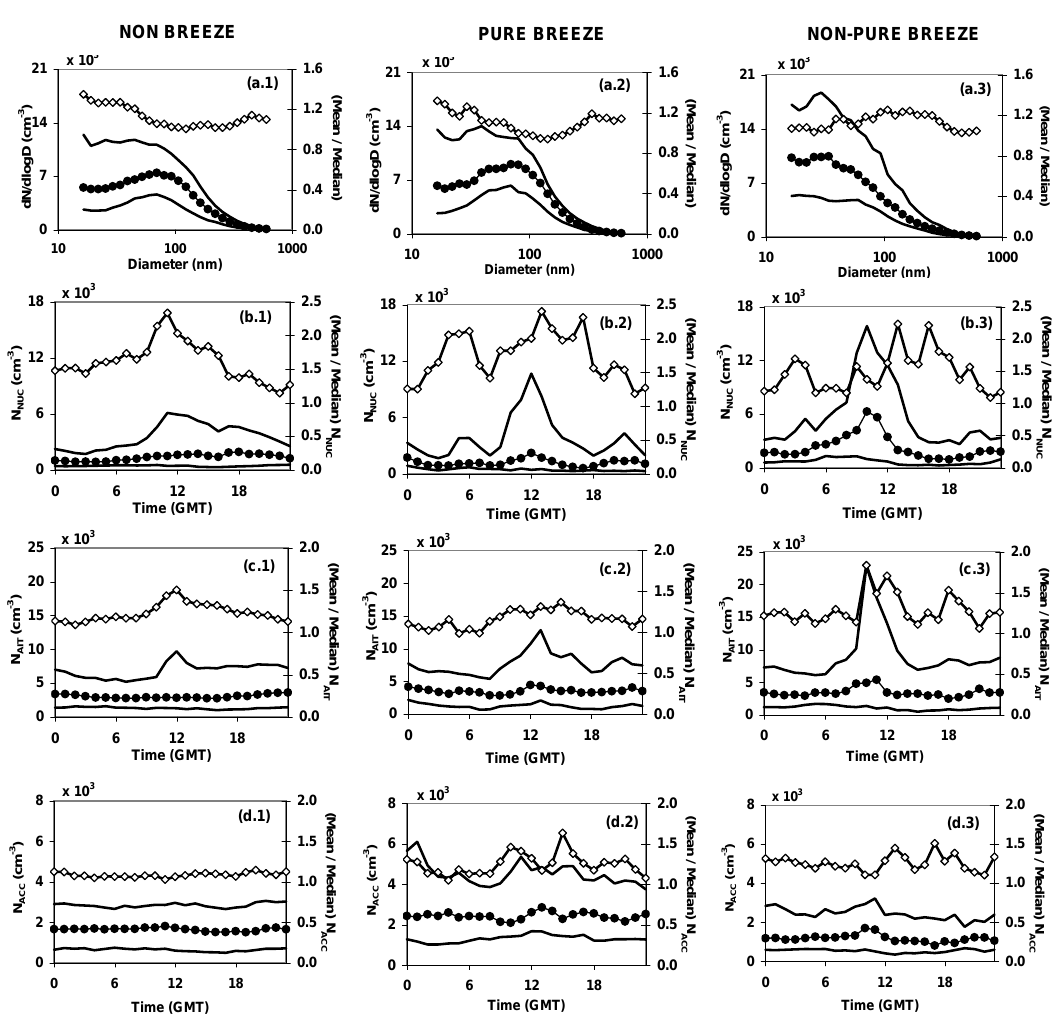
Fig. 11. Median daily (filled symbols), 16th and 84th percentiles (black lines) and the ratio (Mean/Median, open symbols) of particle number size distributions and the modal concentrations for 422 NB-days, 46 PB-days and 36 N-PB-days at El